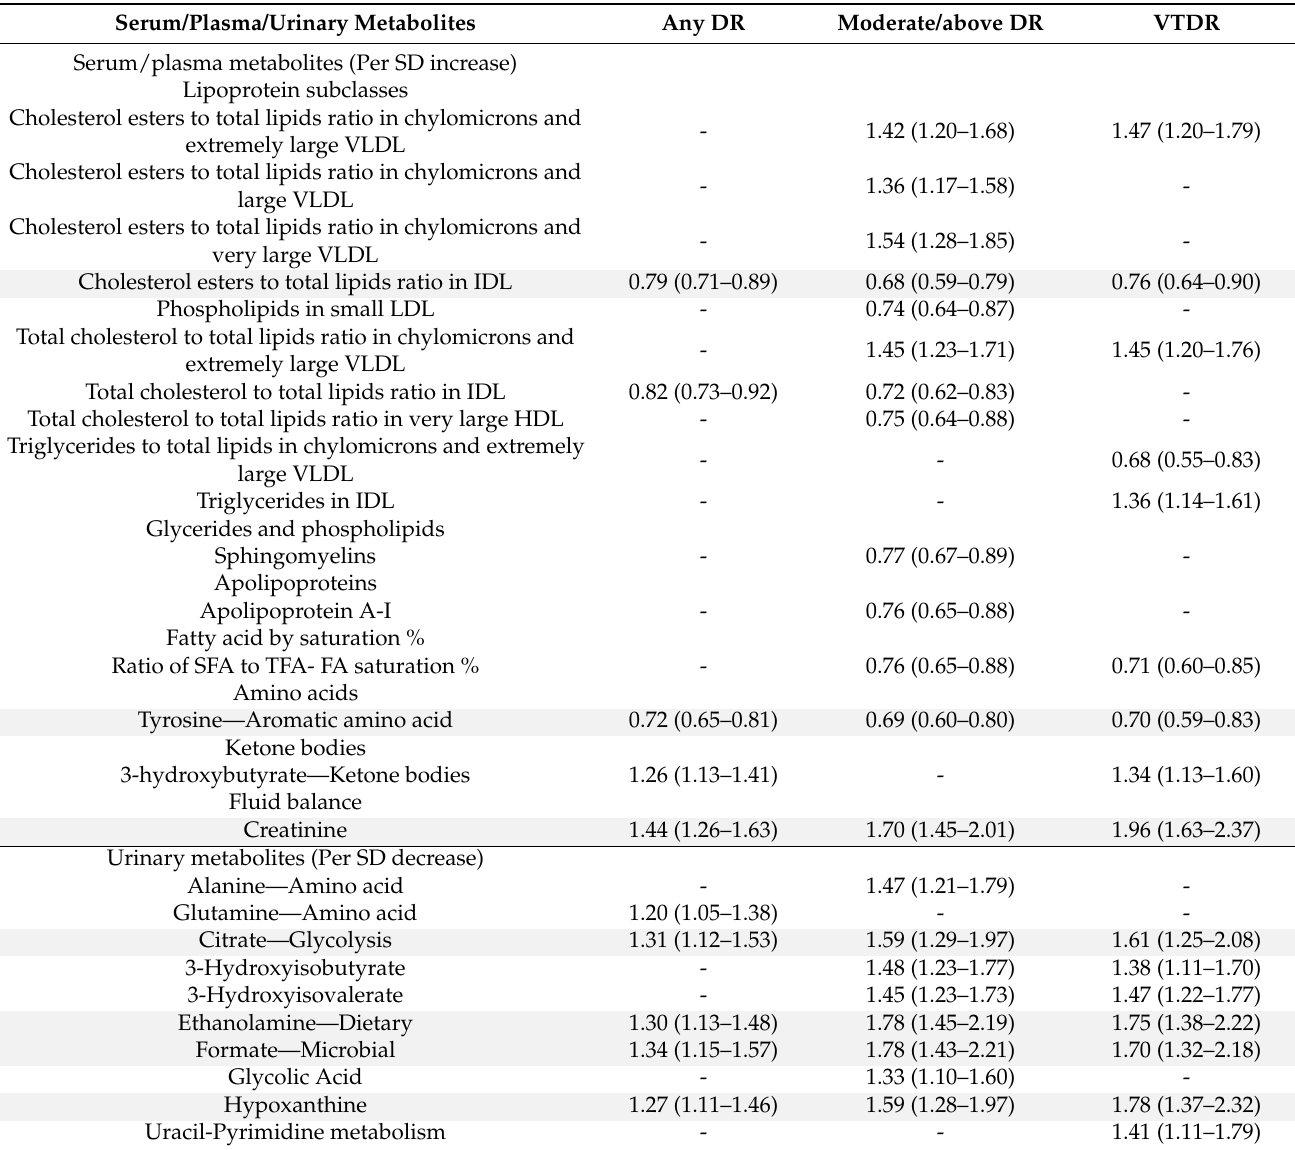
Table 2. Serum/plasma and urinary metabolites associated with any DR, moderate/above DR, and VTDR after